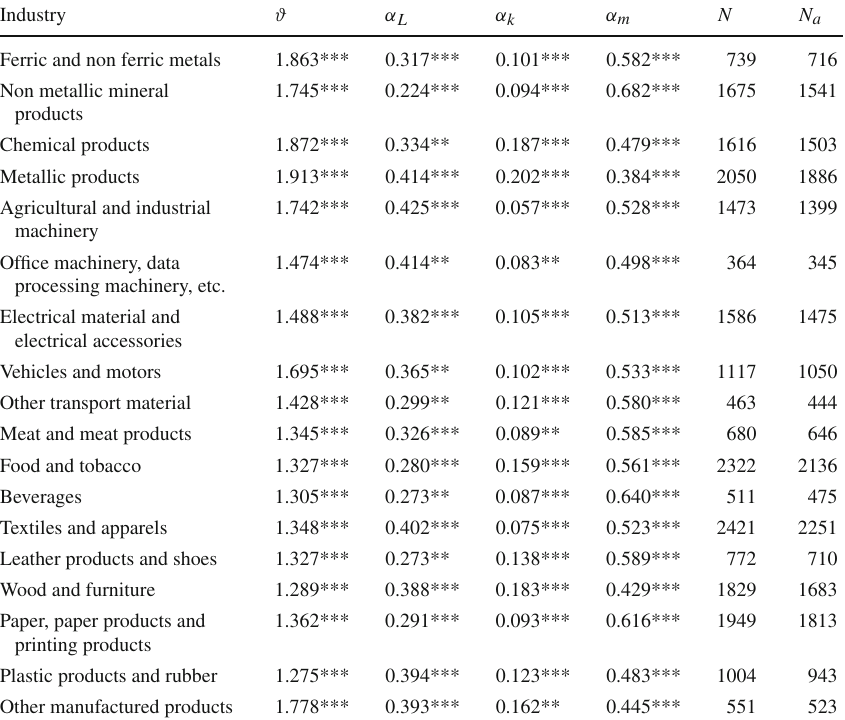
Table 4 Estimates of production function parameters with Levinsohn and Petrin (2003) approach